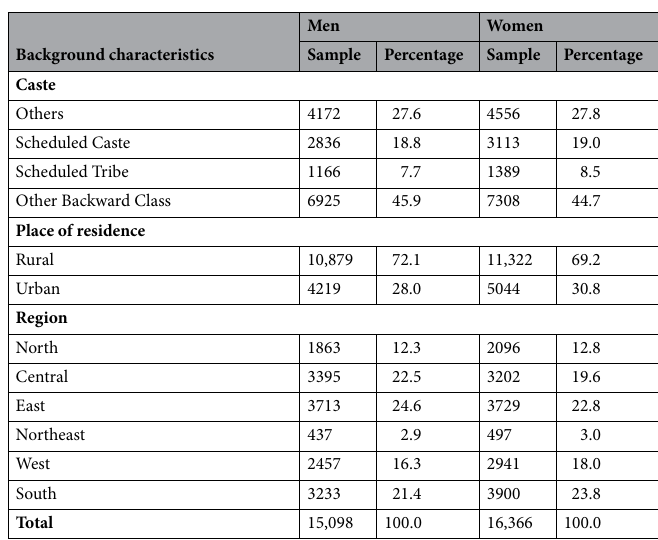
Table 1. Socio-economic and demographic profile of older adults in India, 2017–18. MPCE: monthly per capita consumption